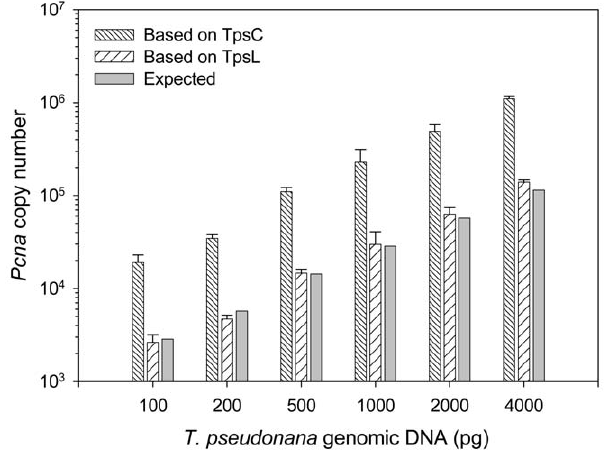
Figure 2. Comparison of qPCR-estimated and expected pcna copy numbers in Thalassiosirapseudonana gDNA samples. The expected copy numbers were calculated based on 1 pcna per genome (0.035 pg of gDNA). Note that the copy number estimates based on the linear standard (TpsL) are similar with the expected numbers, while those based on the circular standard (TpsC) are much higher than the expected values. The error bars denote the standard deviations.